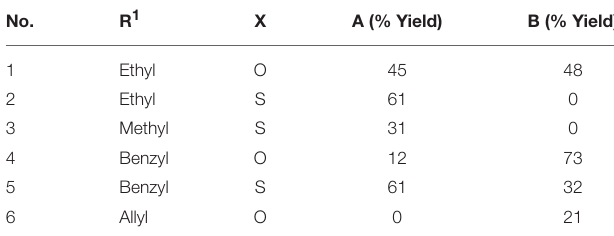
Indium(III) bromide (0.180 g, 0.507 mmol, 0.1 equiv) was added and the reaction mixture was heated under reflux for 7 h, cooled to room temperature, filtered through basic Al 2 O 3 (EtOAc) and concentrated under reduced pressure. The residue was purified by chromatography on SiO 2 (hexanes/EtOAc, 3:1 to 1:3) to afford 1A (0.481 g, 2.26 mmol, 45%) as a light yellow wax and 1B (0.855 g, 2.41 mmol, 48%) as a yellow oil. This procedure was followed for all products in Table 2 and Figure 4 , and spectral properties are presented below. Ethyl